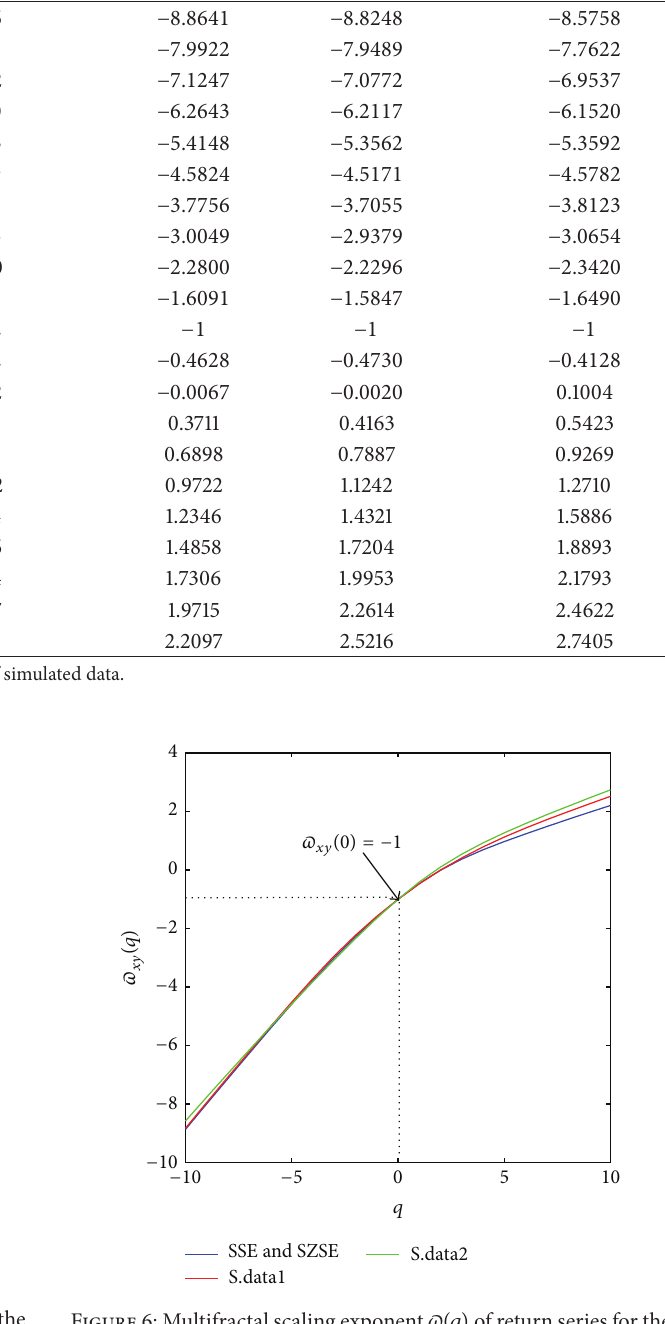
Figure 6: Multifractal scaling exponent 𝜛(𝑞) of return series for the real markets and the financial